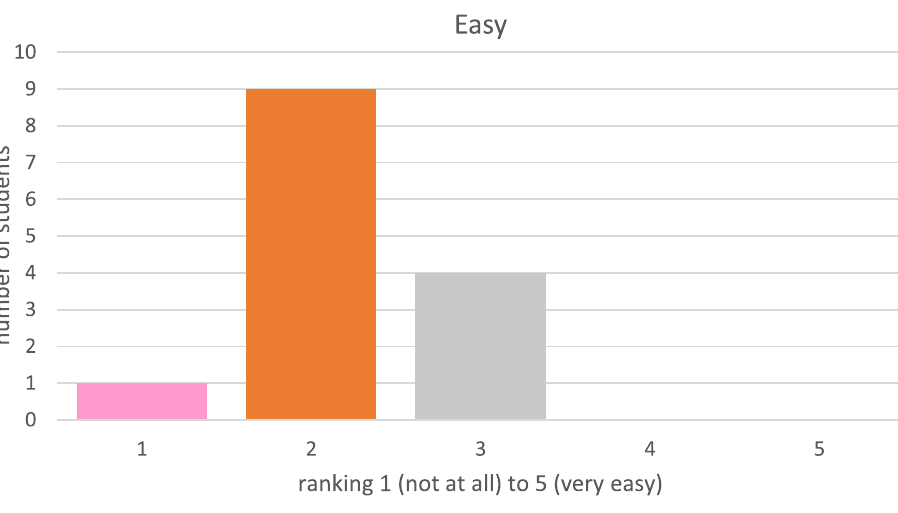
FIG. 19. Distribution of students ’ scores (range: 0 – 5) on the item “ easiness ”